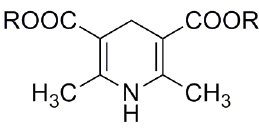
Figure 1 . Hantzsch’s ester. Figure 1. Hantzsch’s ester.